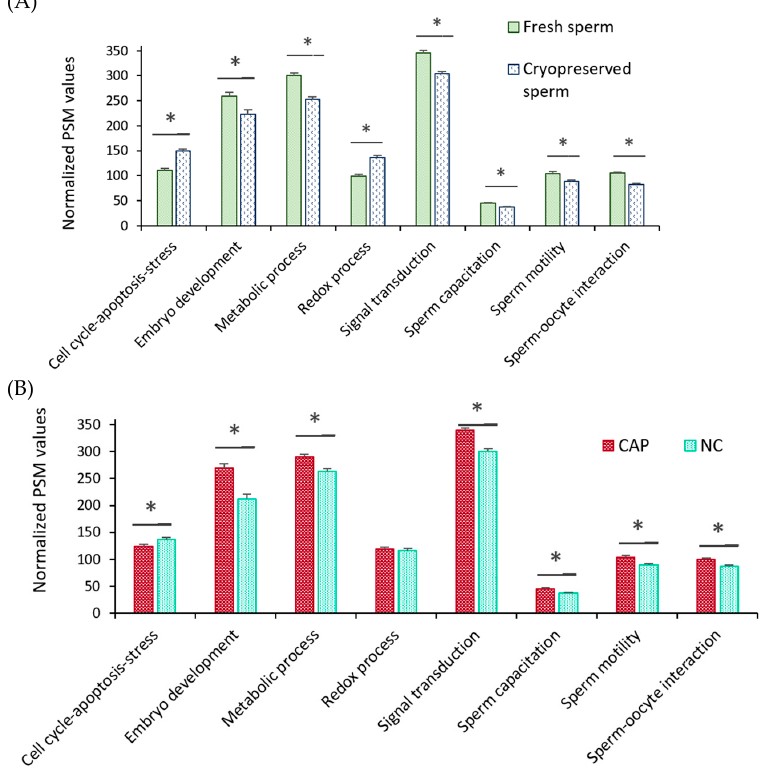
Figure 5. Di ff erent representations of an apoptosis-stress response and other biological processes directly or indirectly involved in reproduction between treatments. ( A ) Comparison of fresh versus cryopreserved ram sperm regardless of the incubation time and media. ( B ) Comparison of sperm incubated in CAP versus NC conditions, regardless of the incubation time and treatment (fresh or cryopreserved sperm). Peptide spectral matches (PSMs) of those proteins involved in each process were normalized against the total number of PSMs and compared using the Bonferroni test, * p <